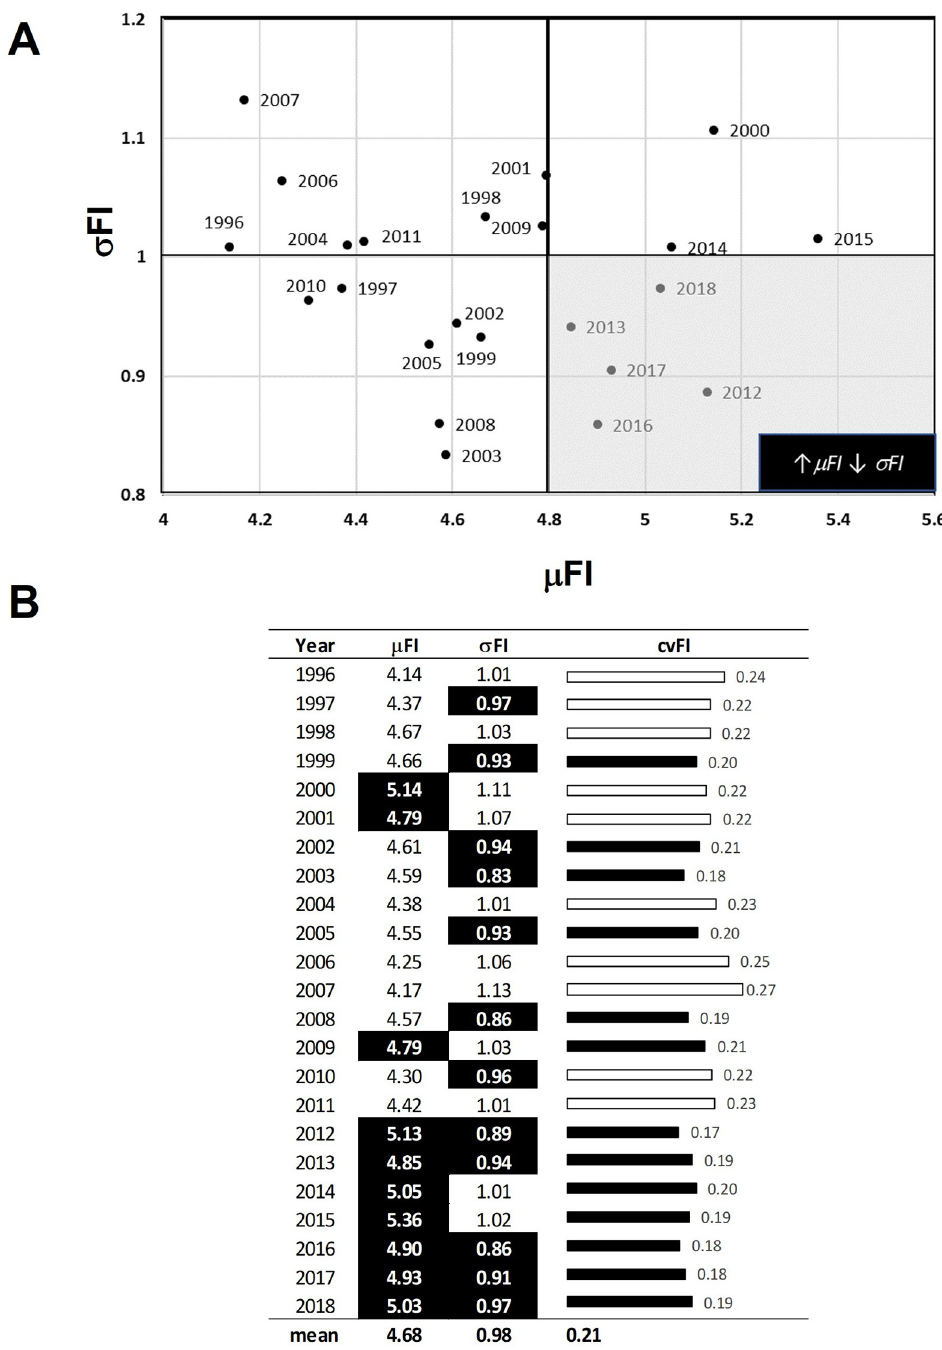
Fig 5. Summary statistics on the spatial variation in physicochemical (PC) dynamics. (A) The μ FI and σ FI plot helps identify more stable (less variable) time periods which are characterized by high μ FI, low σ FI and cvFI (low right corner). (B) Summary statistics for each year including the cvFI. Highlighted values are those meeting the “stable” regimes criteria for the individual measures ( " μ FI, # σ FI and # cvFI).